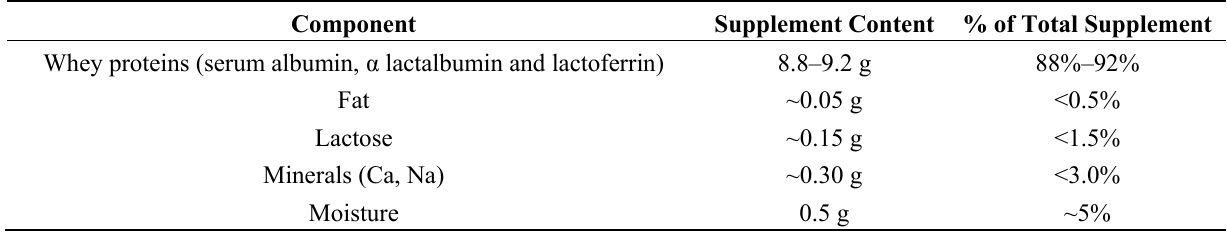
Table 1. Immunocal ® constituents by mass per one packet of supplement a,b